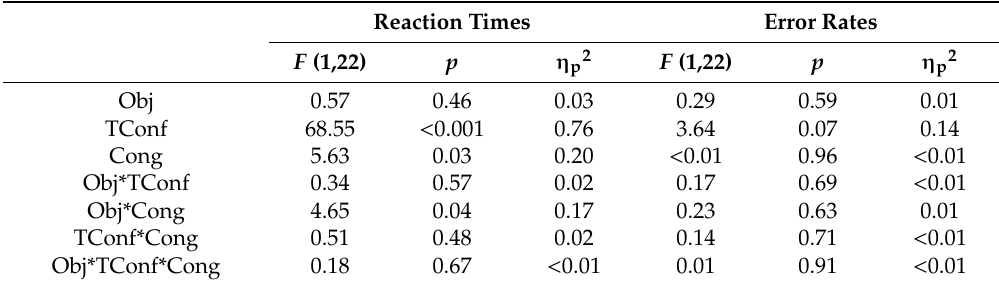
Table A2. Results of ANOVAs on the reaction times and error rates in Experiment 2 as a function of object, target configuration, and cue-target